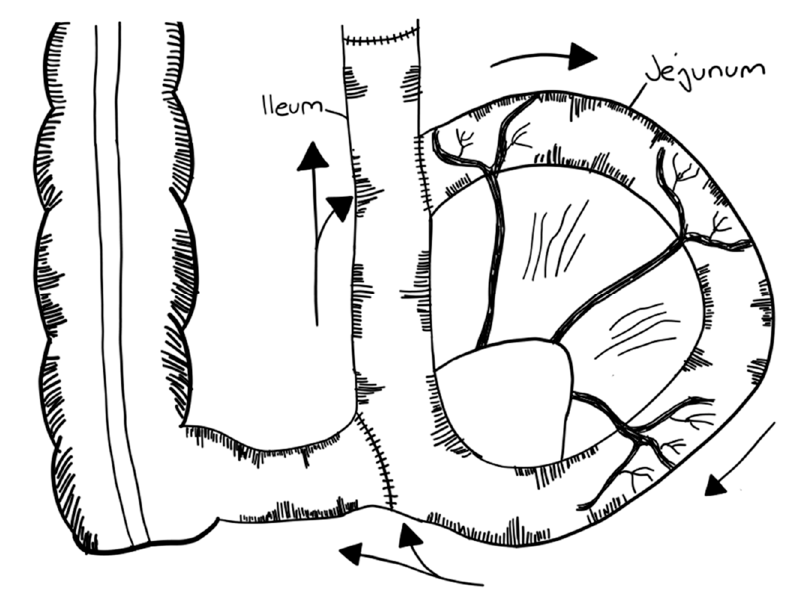
Figure 14. Reversal of parts of the small intestine and creation of an ileal loop. The arrows indicate the movement of the small intestinal content. Machby et al. [170].